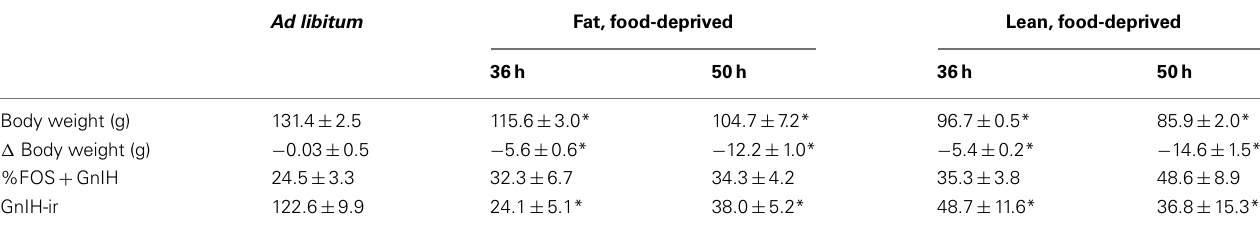
Table 2 | Mean and SEM for body weight, change in body weight, percent of GnIH-Ir cells double-labeled for Fos, and the number of GnIH cells in Syrian hamsters from Experiment 2B. Hamsters were sacrificed in the early follicular phase of the estrous cycle just 36 or 50h after the start of food deprivation on the morning of day 1 of the estrous cycle to determine whether there might be changes in GnIH cells that would predict reproductive states at the time of the LH surge that would be expected to occur on day 4 of the estrous cycle.Anestrous was expected to occur only in lean food deprived females.